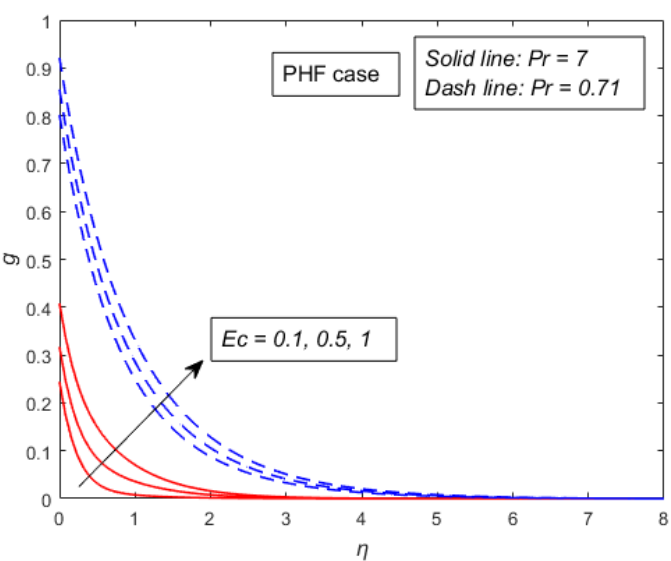
Figure 11. Variation of the temperature profile for different values of Eckert number Ec and Prandtl number Pr for the PHF case when n = 3, K = 1, and M = 0.